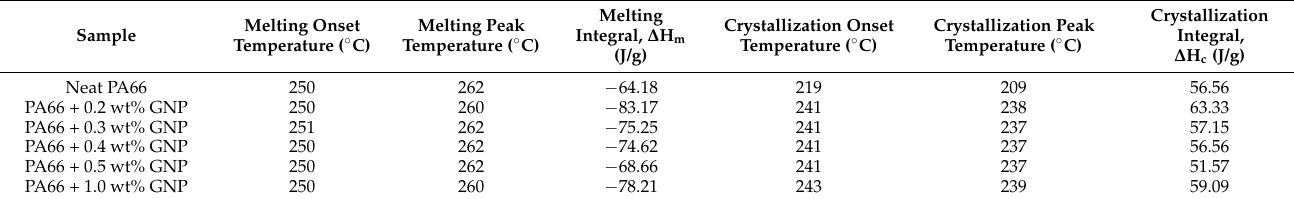
Table 4. Crystallinity degrees of neat PA66 and its GNP-based nanocomposites obtained from DSC